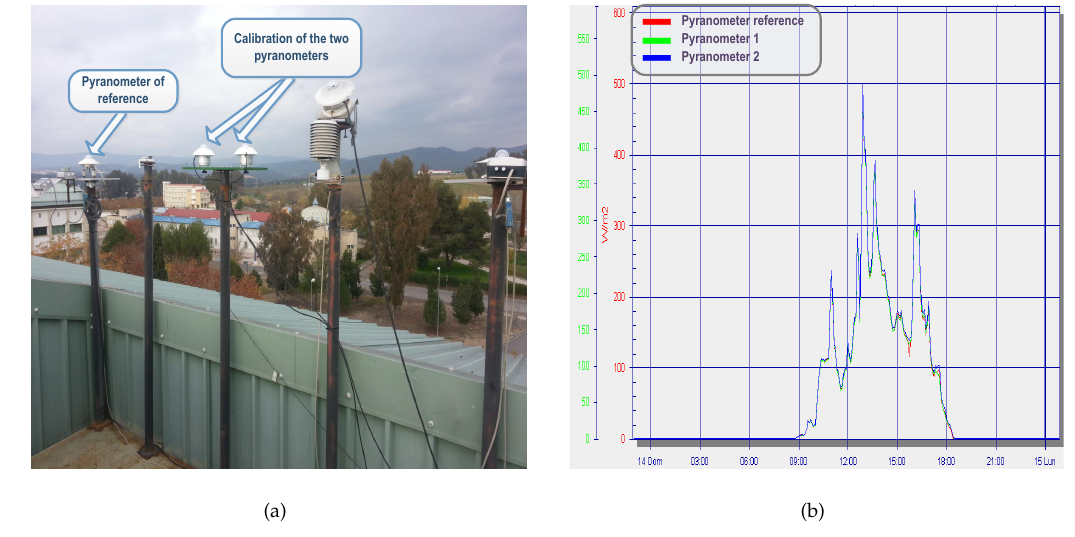
Figure 11. Calibration of the pyranometers: ( a ) Detail of the pyranometer on the radiometric installation; ( b ) Irradiance data recorded during a